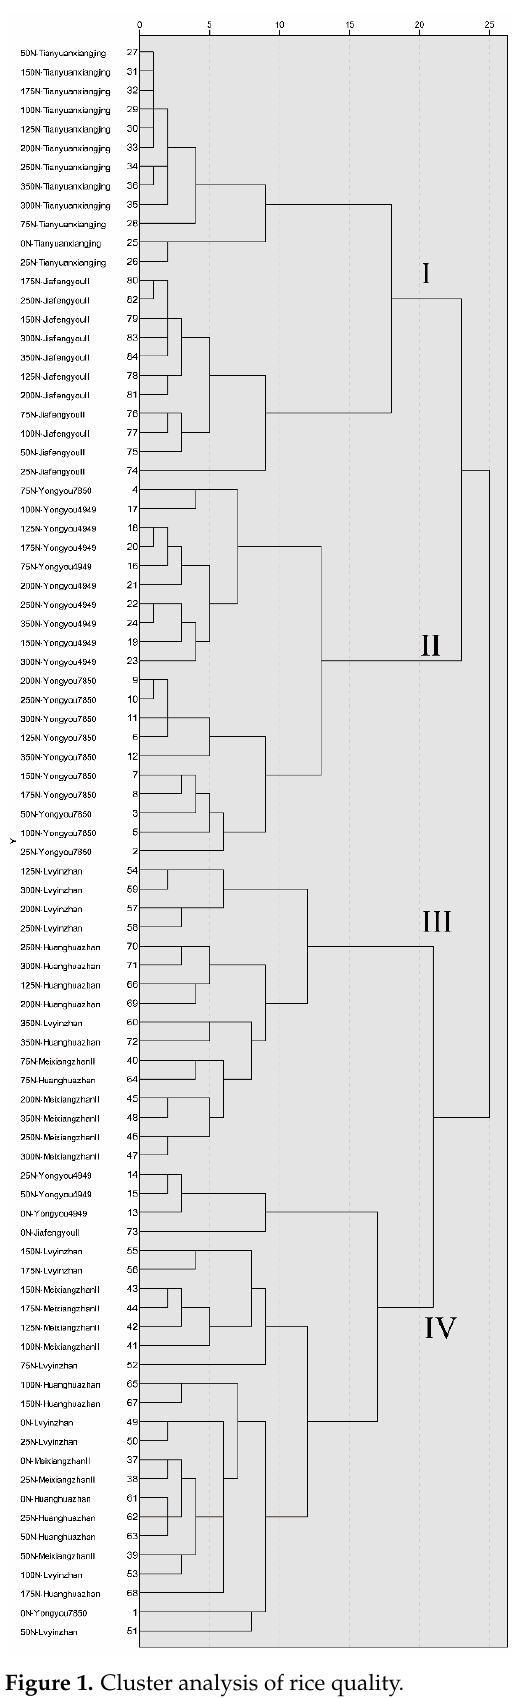
Figure 1. Cluster analysis of rice quality.